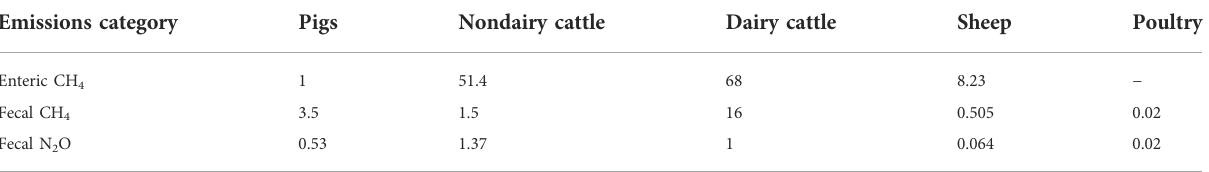
TABLE 1 GHG emission factors from different emission categories and animal